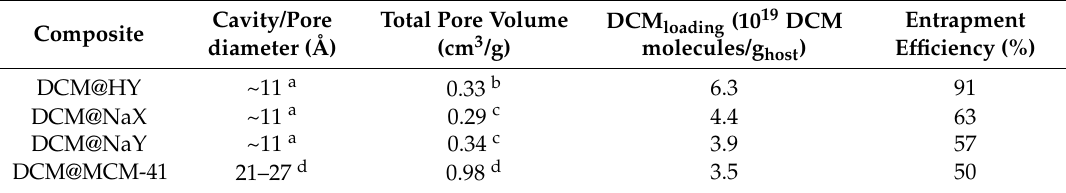
Table 1. Values of cavity/pore diameter and total pore volume of the used zeolites (HY, NaX, and NaY) and MCM-41 together with the loadings and entrapment efficiencies for DCM dye interacting with the studied